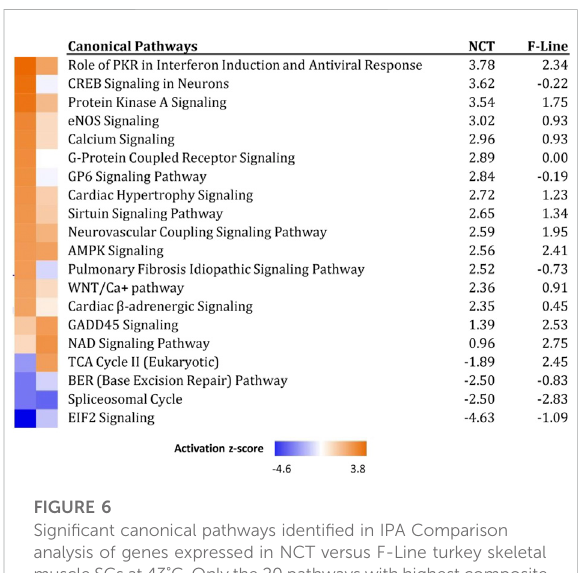
FIGURE 6 Signi fi cant canonical pathways identi fi ed in IPA Comparison analysis of genes expressed in NCT versus F-Line turkey skeletal muscle SCs at 43 ° C. Only the 20 pathways with highest composite Z-scores are